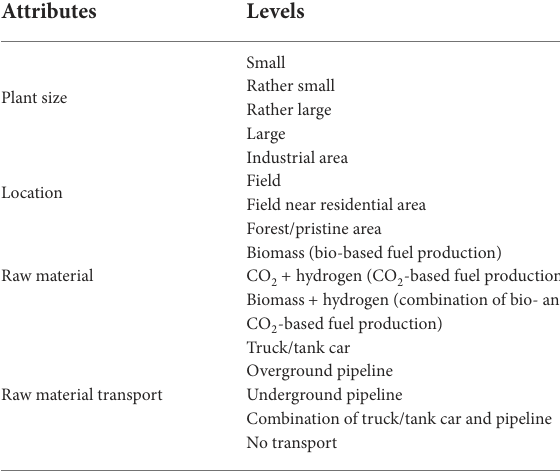
TABLE 1 Attributes and levels used in the conjoint